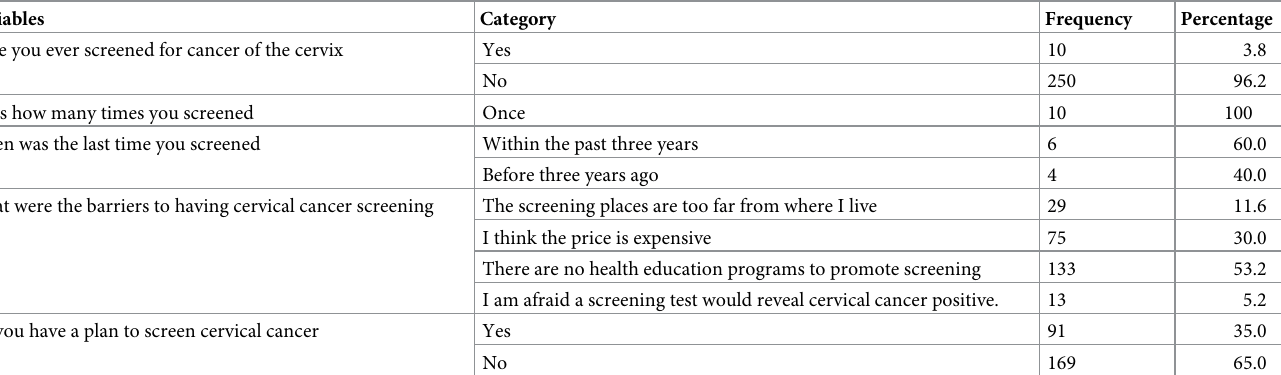
Table 4. Practice of cervical cancer screening among reproductive age group women in districts of Gurage zone, Southern Ethiopia, 2019. Variables